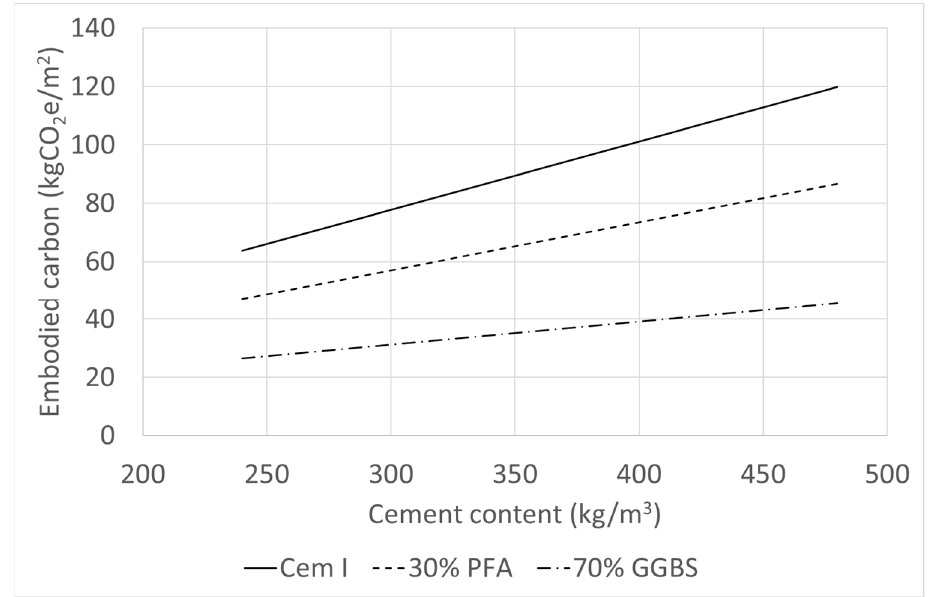
Figure 5. Embodied carbon in a 250 mm thick 1 m × 1 m panel for different cement/binder combina- tions.